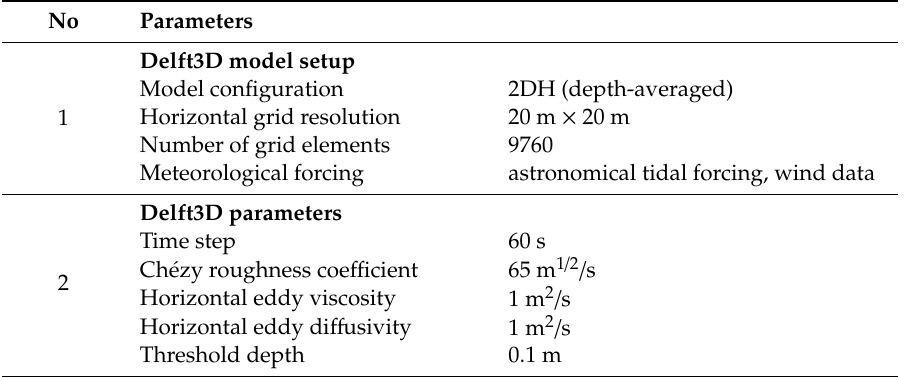
Table 4. Model Setup and